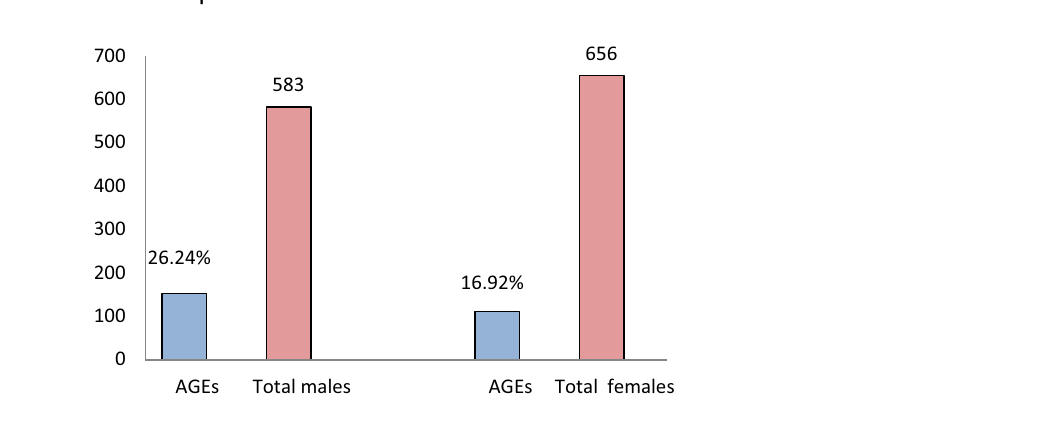
Figure 4. Distribution of AGEs by sex in all